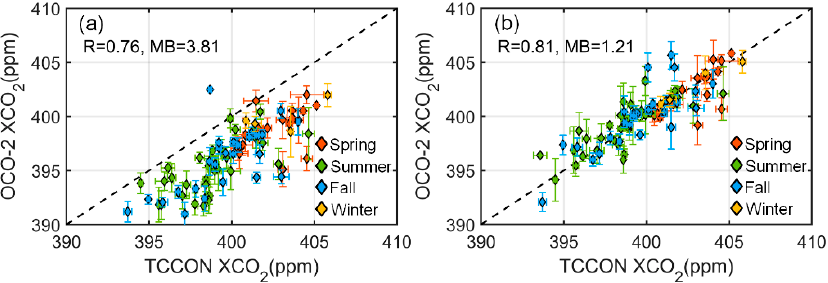
Figure 9. Scatterplots of seasonal daily average XCO 2 from OCO-2 versus collocated TCCON observations. The dashed line is the one-to-one ratio line. The red, green, blue, and yellow points represent the spring, summer, fall, and winter results. ( a ) Results before linear regression correction; ( b ) results after linear regression correction.